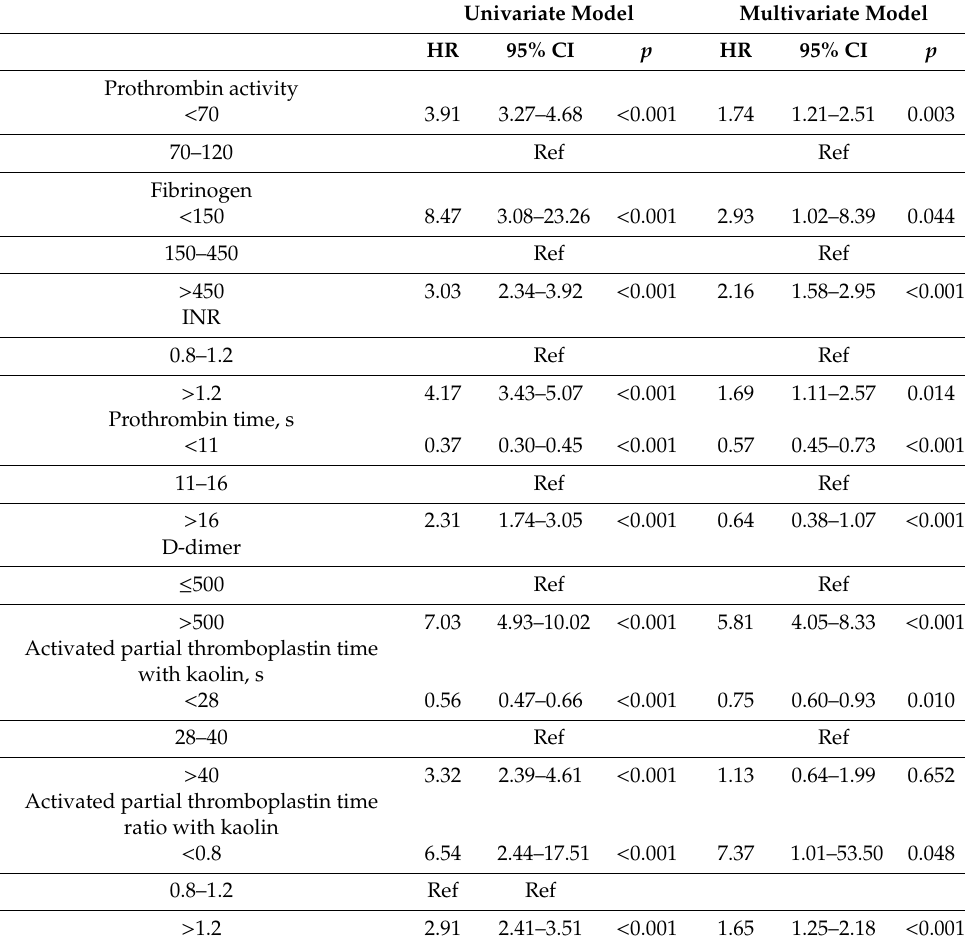
Table 4. Univariate and Multivariate Cox Models.